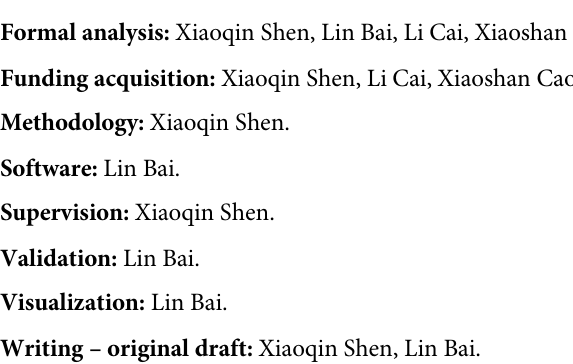
S2 Fig. Visualization results. They were coded by FreeFem++ and visualized by